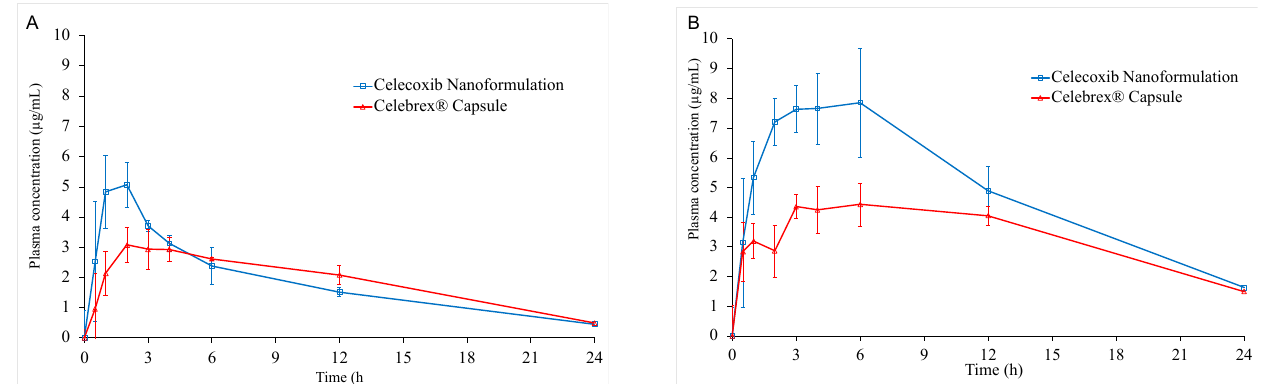
Figure 10. Plasma concentration vs. time profiles of CXB after a single oral administration of CXB nanoformulation and Celebrex ® capsule at a dose of 10 mg/kg ( A ) and 40 mg/kg ( B ). Data are pre-sented as mean ± SD (n = 5).